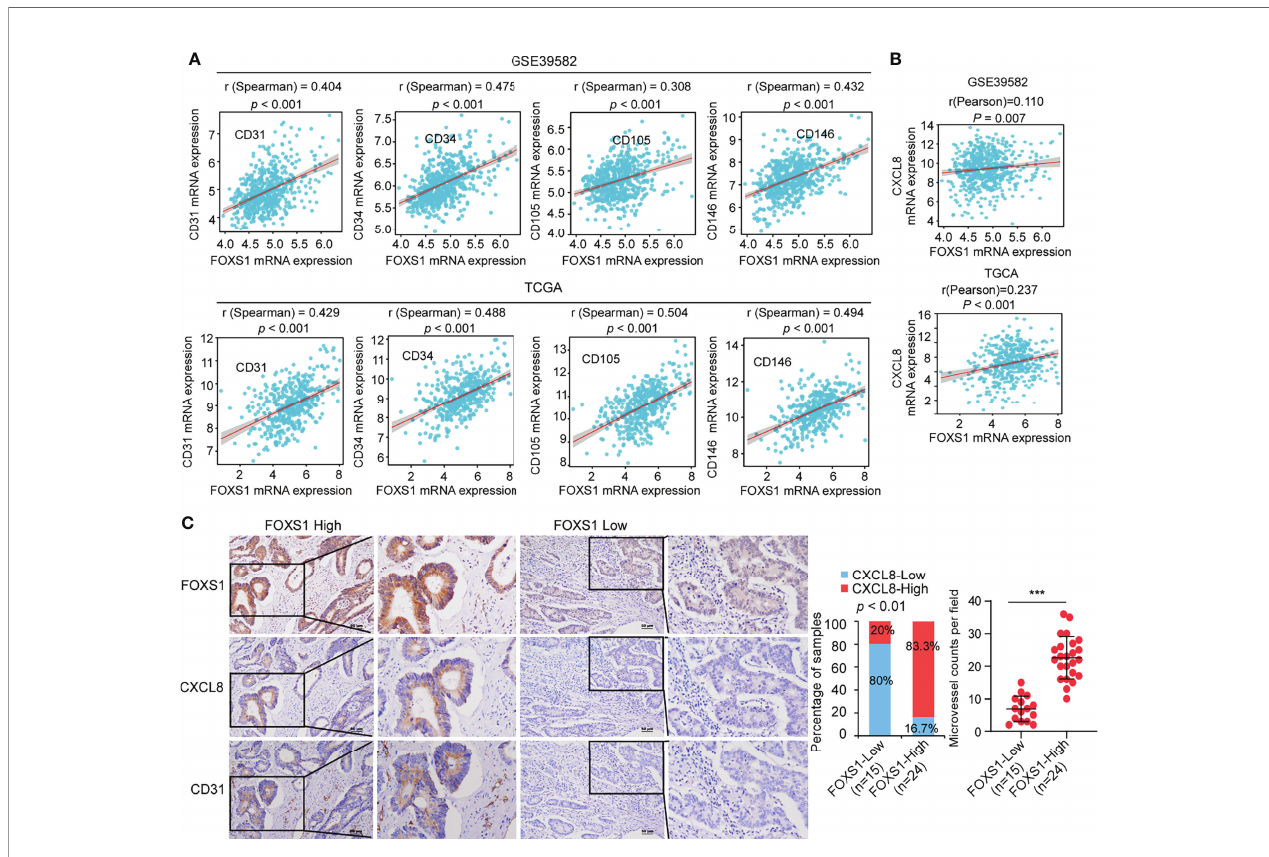
FIGURE 6 | FOXS1 expression is positively correlated with angiogenesis and CXCL8 expression in CRC. (A) Correlation analysis of FOXS1 and CD31, CD34, CD105, or CD146 in GSE39582 and TCGA-CRC. (B) Correlation analysis of FOXS1 and CXCL8 in GSE39582 and TCGA-COAD ( r = 0.110, p < 0.01; r = 0.237, p < 0.001). (C) The expressions of FOXS1, CXCL8, and CD31 protein in specimens, including 39 CRC tissue specimens, were examined by IHC. Representative IHC images (left) and correlation analysis (right) of FOXS1 and CXCL8 expression or microvessel count (indicated by CD31-positive cells) in per fi eld are shown. Scale bars: 50 µm. *** p <